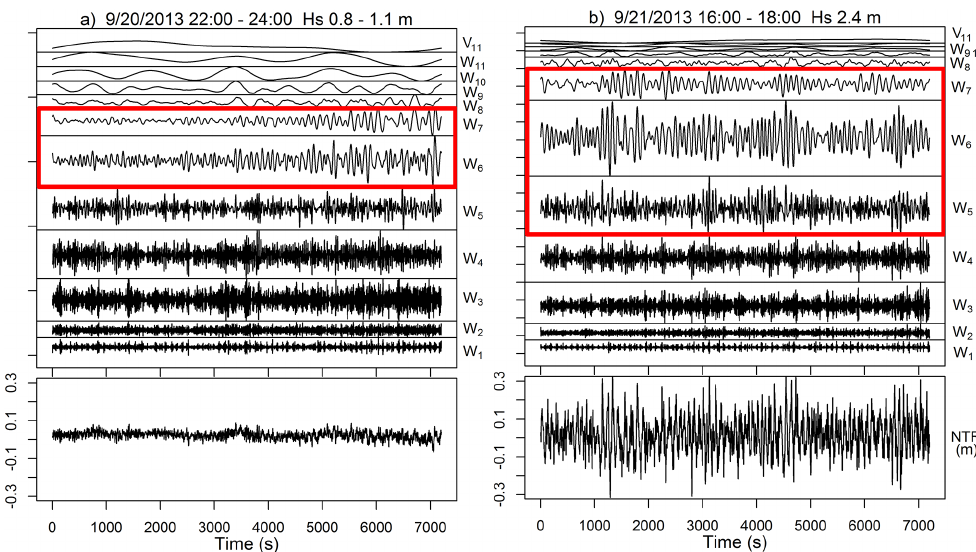
Figure 10. (a) Discrete wavelet transform decomposition of nontide residual during a 2h period when deep water significant wave height increased from 0.8 to 1.1m. The red box highlights the W 6 and W 7 wavelet levels exhibiting emergence of energy in these two bands as wave height increases. (b) Discrete wavelet transform decomposition of nontide residual during a 2h period when deep water significant wave height was 2.4m. The red box highlights the W 5 , W 6 and W 7 wavelet levels exhibiting dominance of energy in these bands and amplitude modulation. Power spectral density estimates of these 2h period are shown in Fig.